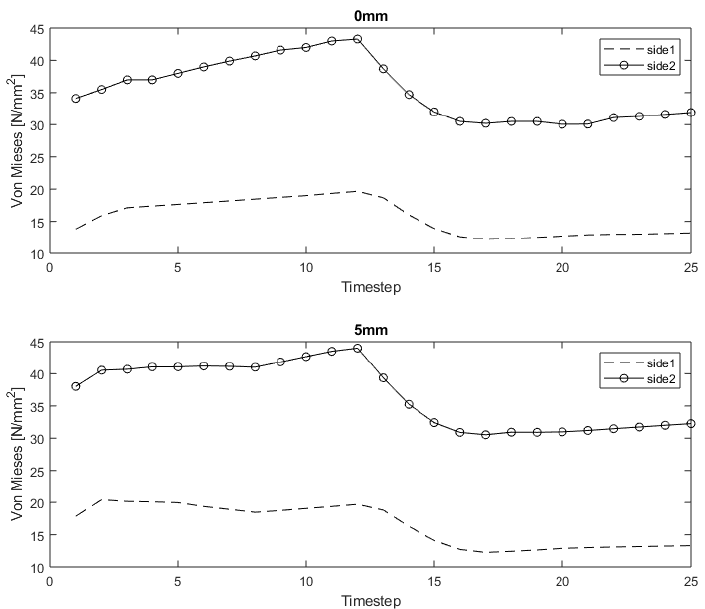
Figure 8. No pit, side 1 and 2 ( Top )—5 mm pit comparison side 1 and 2 ( Bottom ).